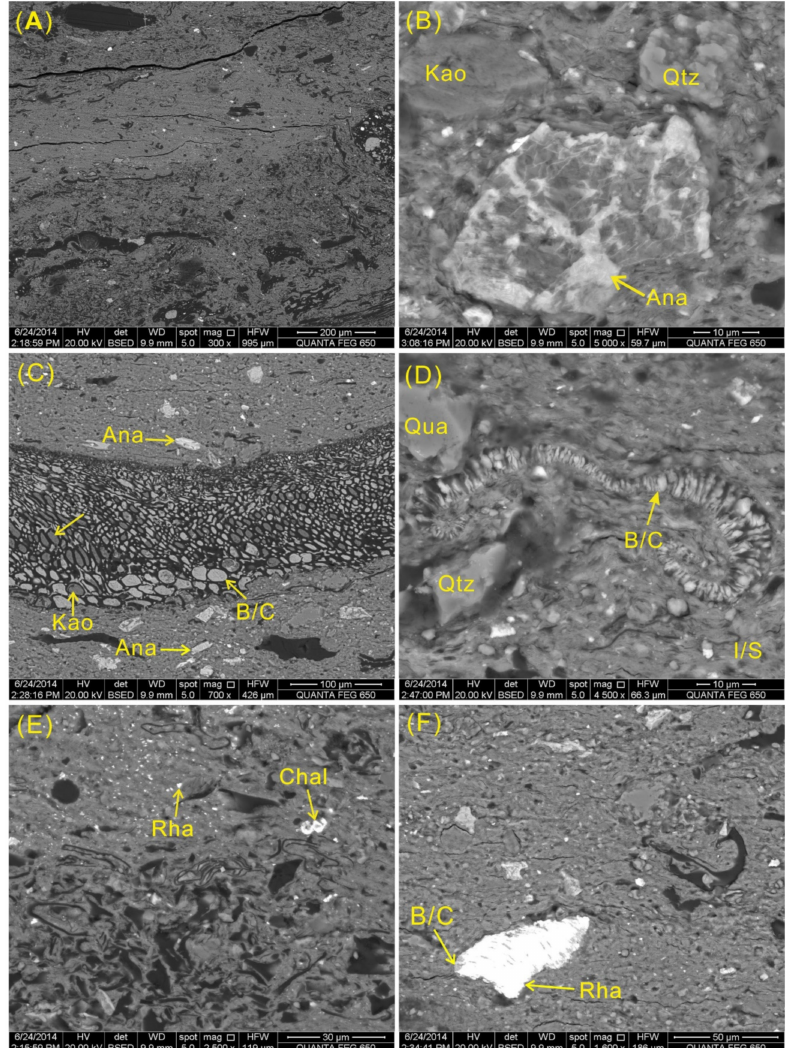
Figure 15. SEM back-scattered electron images of minerals in B3-f. ( A ) Clay minerals as matrix with abundant plant residues. ( B ) Kaolinite, authigenic quartz, and highly altered anatase with network texture. ( C ) Cell-filling kaolinite and B/C. ( D ) Vermicular B/C and authigenic quartz. ( E ) Small grains (<1 µ m) of rhabdophane. ( F ) Rhabdophane and associated B/C. B/C: interstratified berthierine/chamosite. Kao: kaolinite. Qtz: quartz. Ana: anatase. I/S: mixed layer illite/smectite. Chal: chalcopyrite. Rha: